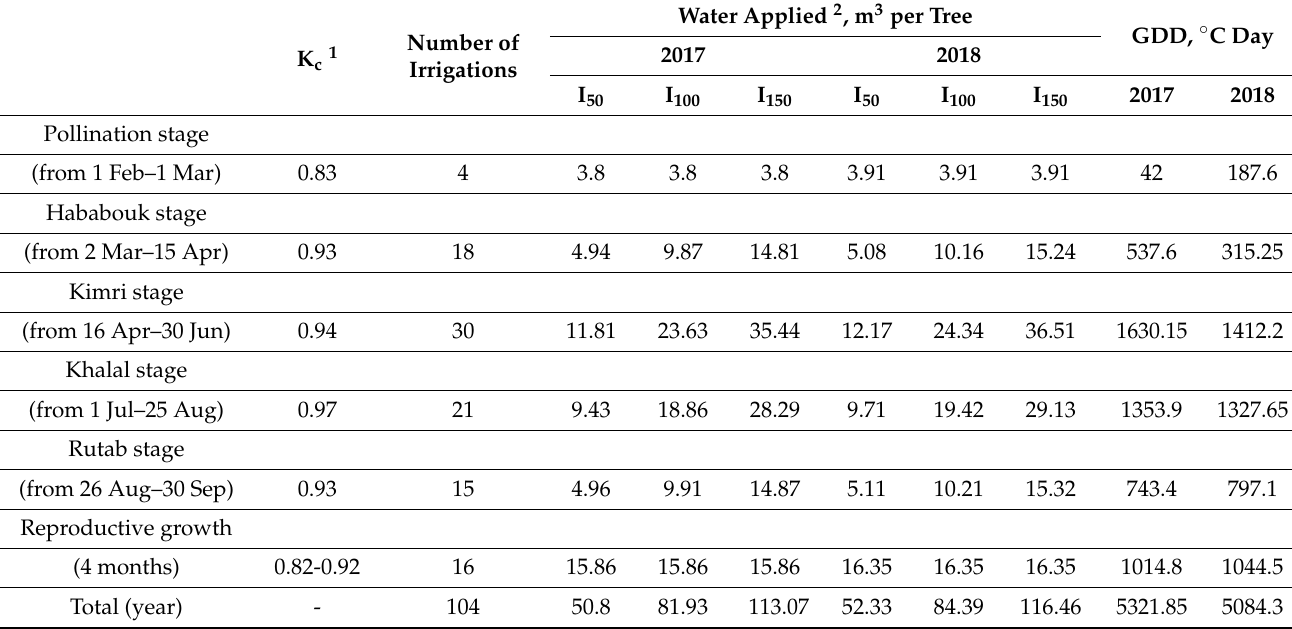
Table 2. The crop coefficient (K c ), number of irrigations, water applied in the irrigation level treatments, and accumulated heat units during the date palm growing